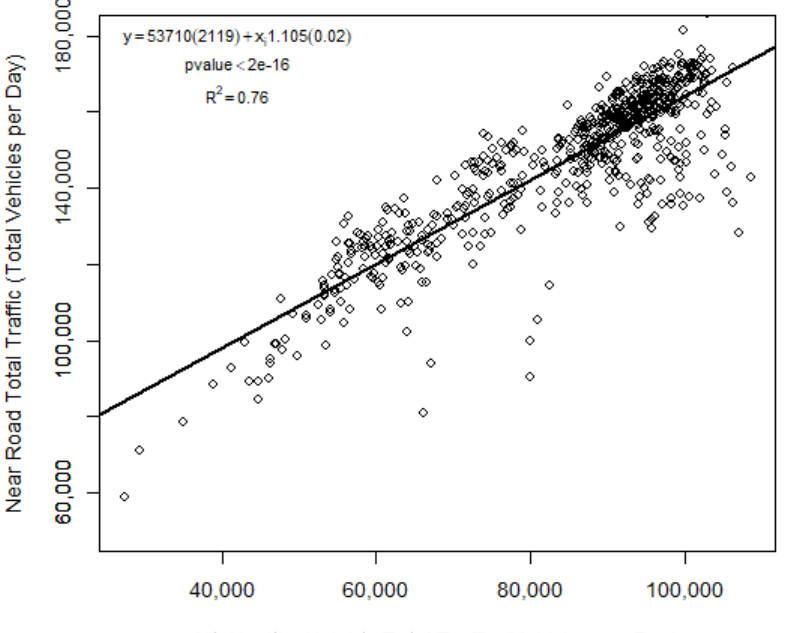
Figure 4. Results of using Mt. Healthy total traffic counts to predict Near Road total traffic counts via linear regression. The regression equation, p -value for fit of predictor, and R 2 are shown in the top left of the figure.